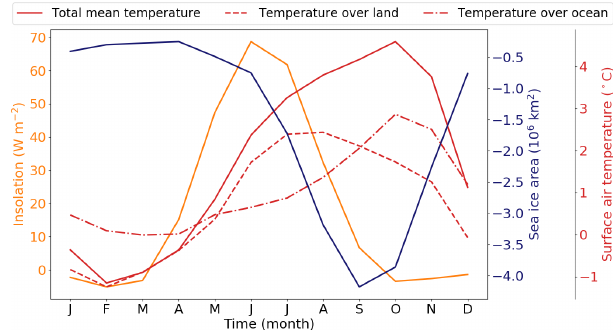
Figure 6. Annual cycles of solar radiation (orange line), surface air temperature (red lines) and sea ice area (dark blue line) LIG–PI anomalies. Variables are averaged between 60 and 90 ◦